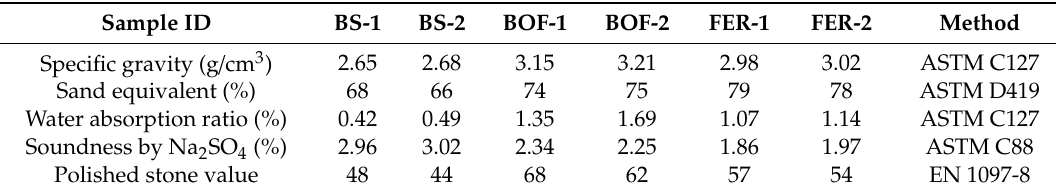
Table 1. Basic properties of